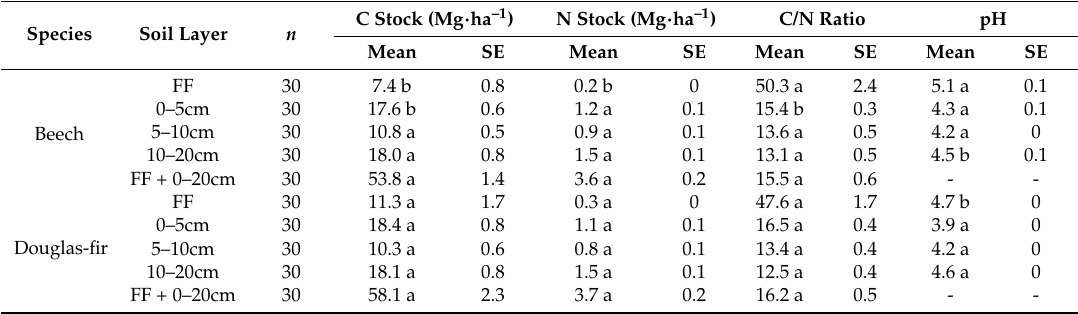
Table 4. Mean and standard error (SE) for the examined soil properties by tree species and soil layer. Species